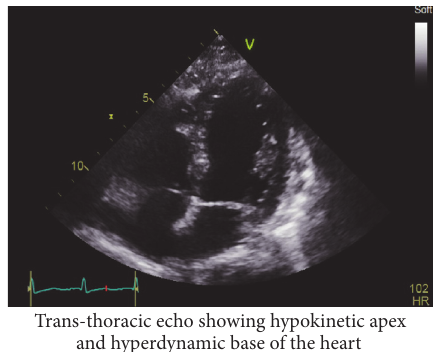
Figure 1: 4-chamber view transthoracic echocardiogram.